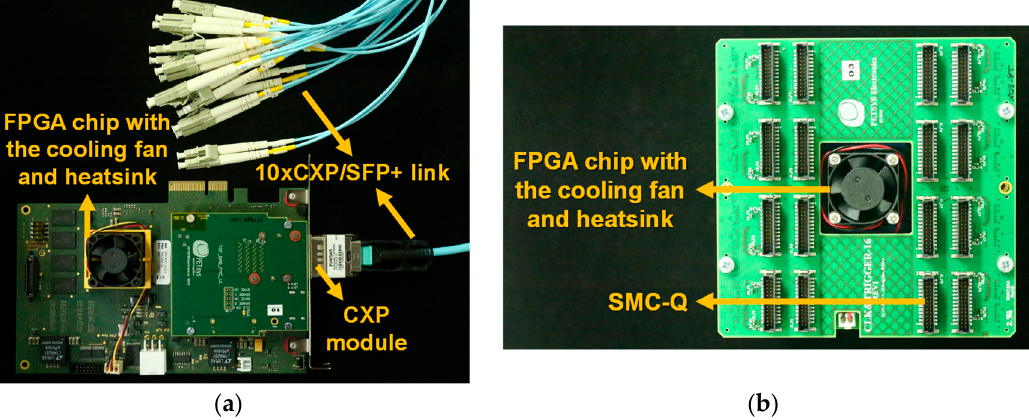
Figure 6. Photographs of the DAQ board ( a ) and the Clock&Trigger board ( b ). For the developed TOF brain PET, a 10xCXP/SFP+ link was used to communicate with the DAQ board.